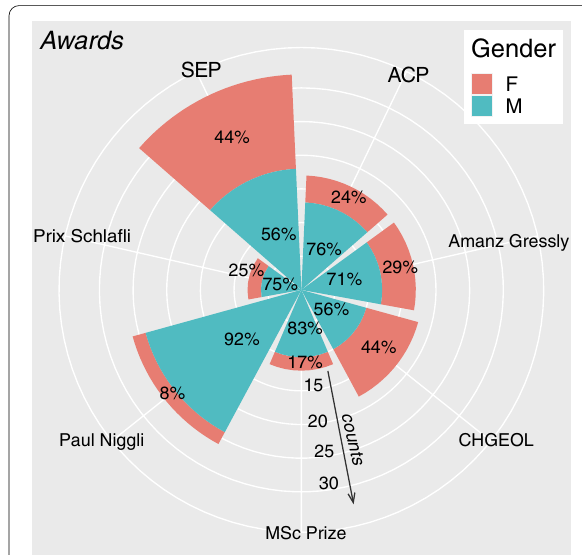
Fig. 12 Gender distribution for different prizes. Paul Niggli medal, Prix Schäfli (only for prizes appointed to a PhD in geosciences), Schnee‑Eis‑Permafrost (SEP) award, Atmospheric Chemistry and Physics (ACP) award, and best MSc thesis award (MSc Prize), Amanz Gressly prize (for major contribution in the field of paleontology), Swiss Geologist association (CHGEOL). White lines correspond to counts with five counts